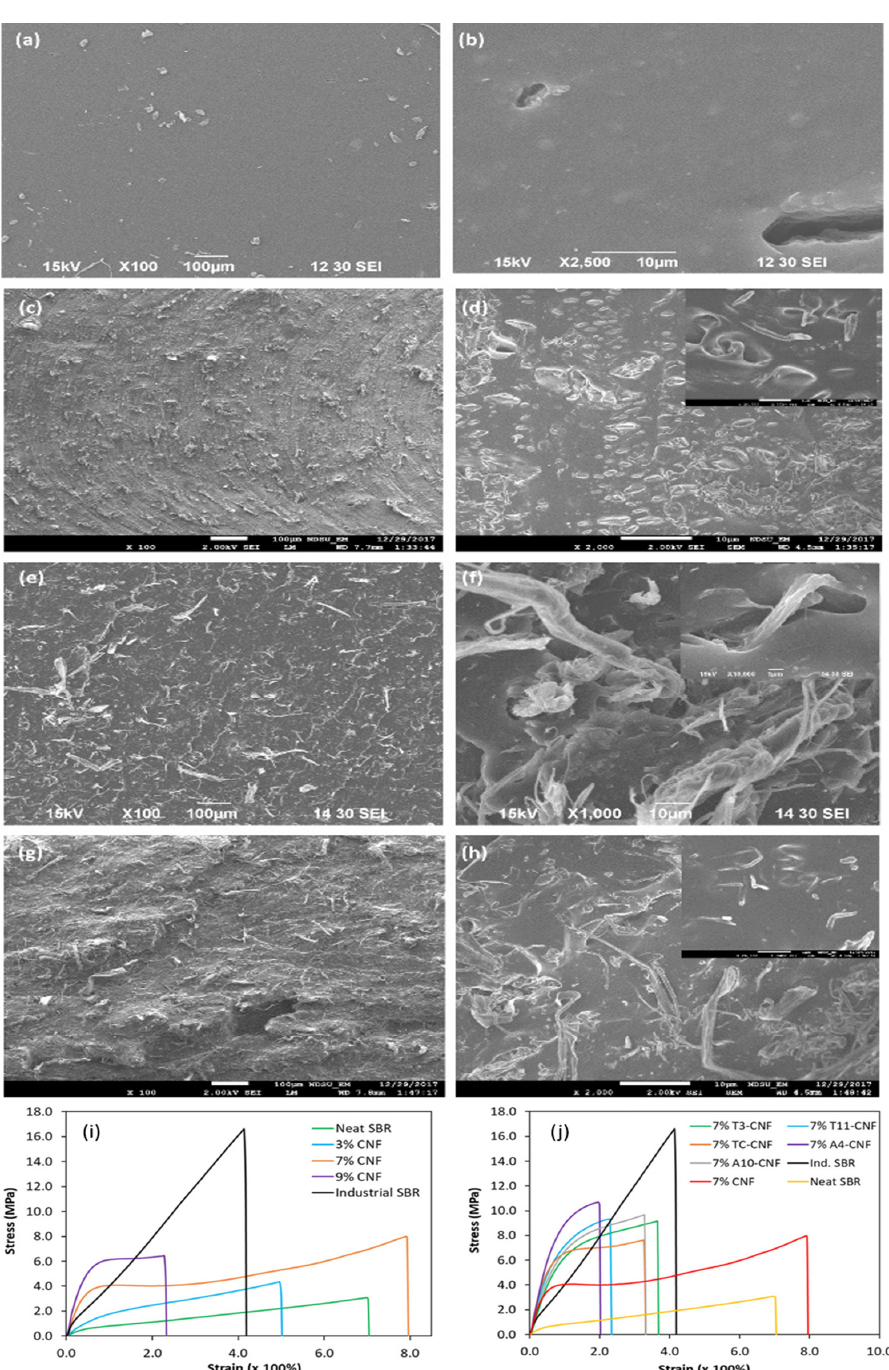
Figure 9. SEM images of tensile fractured surfaces of neat styrene-butadiene rubber (SBR) and SBR/CNFs nanocomposites. ( a , b ) Neat SBR; ( c , d ) 3% CNFs; ( e , f ) 7% CNFs; and ( g , h ) 9% CNFs. Representative tensile stress − strain curves of SBR nanocomposites reinforced with ( i ) pristine CNFs and ( j ) various functionalized CNFs. Adapted with permission from [25]. Copyright 2019 American Chemical Society.